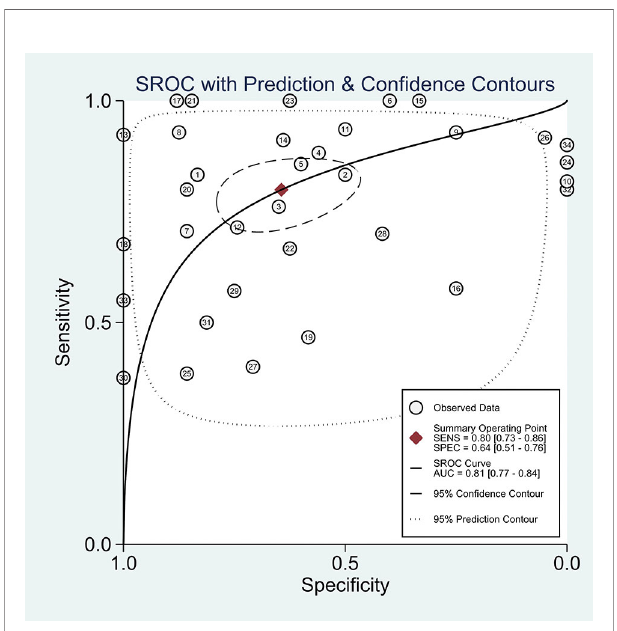
FIGURE 8 | The SROC curve of the differential diagnostic value of histology in MPLC and